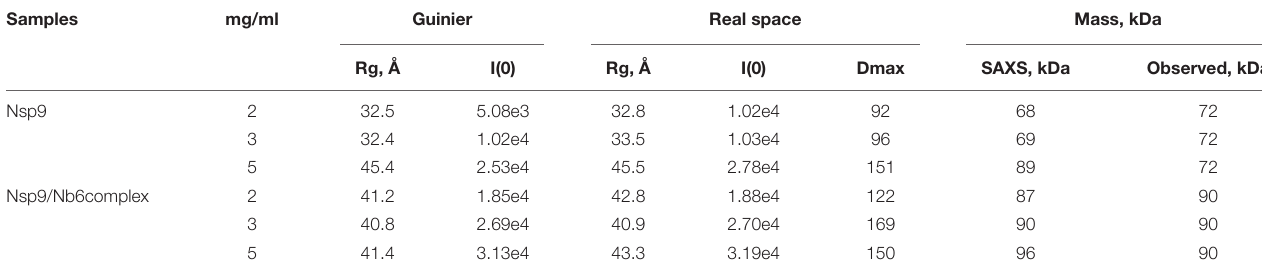
residues Ile588, Asp590, Leu643 and Asp646 and Nb6 aa